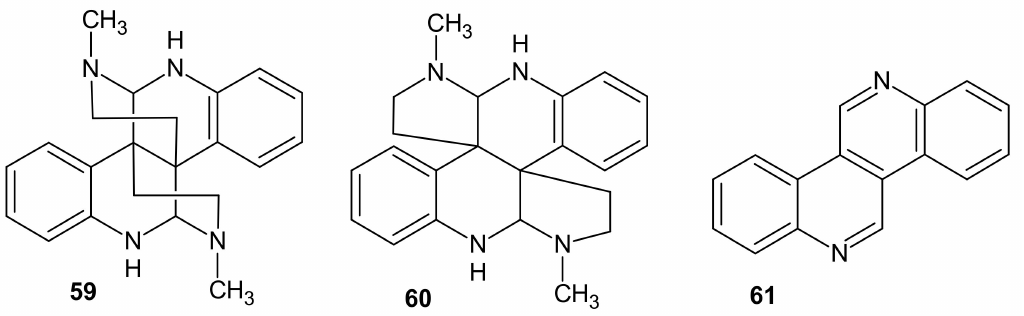
Figure 19. Calycanthine 59 , isocalycanthine 60, and calycanine 61